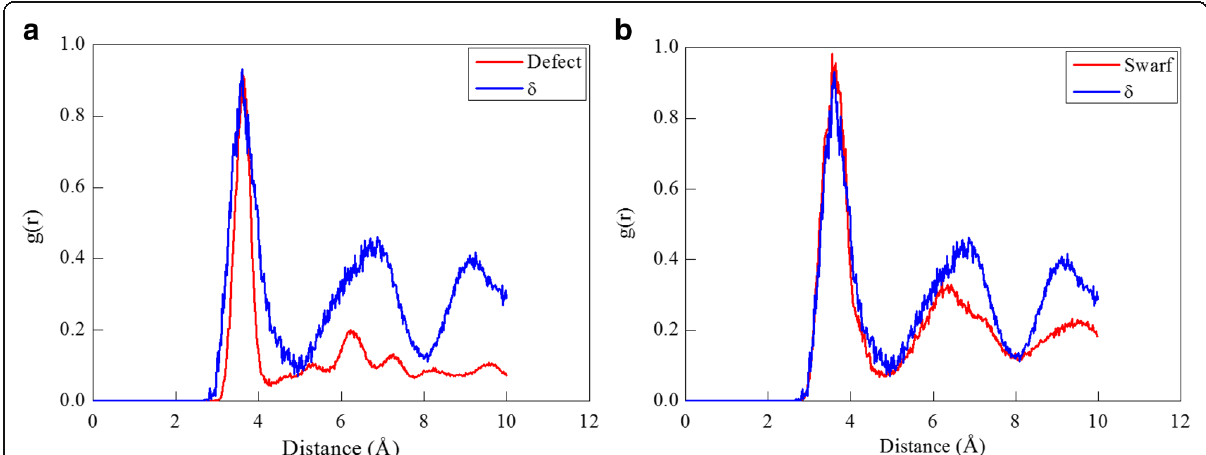
Fig. 5 Analysis of phase transformation in cutting process; (color online) analysis of phase transformation in the diamond cutting of Ce(010) under a rake angle of 0°. RDF of a workpiece and b chip after the